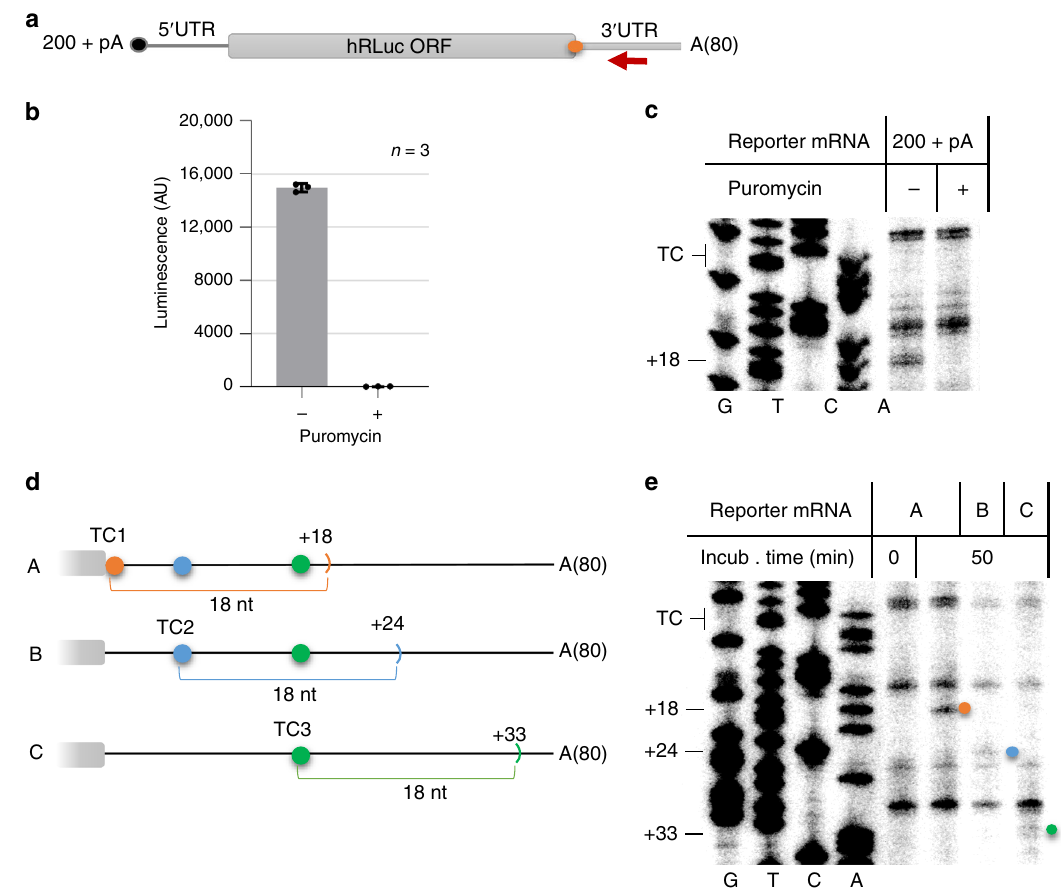
Fig. 1 Toeprint analysis allows the detection of ribosomes at the termination codon of in vitro translated reporter mRNAs. a Schematic representation of the in vitro synthesized capped (black dot) and polyadenylated reporter mRNA coding for humanized Renilla Luciferase (hRluc). The red arrow denotes the radiolabeled toeprint primer binding 66 nts downstream of the TC (orange dot). The 200 nt-long 3 ′ UTR is followed by an 80 nts long template- encoded poly(A) tail depicted as A(80). b Rluc activity measurements of in vitro translation reactions. Luminescence is depicted as arbitrary units (AU), mean values ± standard deviations of 3 technical replicates are shown, values of the individual measurements are indicated by dots. c Toeprint analysis with the 200 + pA reporter transcript shown in a . Translation was performed in HeLa lysates for 50 min in the presence or absence of puromycin. To locate the positions of the toeprints, a Sanger sequencing reaction was run in parallel (G, T, C, A) using the same primer. The positions of termination codon (TC) and the toeprint band 18 nts downstream of the fi rst nucleotide of the TC ( + 18), which originates from ribosomes located at the TC, are indicated. d Schematic representation of in vitro synthesized Rluc reporter transcripts A ( = 200 + pA), B and C, which differ with regards to the position of the termination codon (TC1, TC2, and TC3, respectively). The expected position of toeprints originating from ribosomes at the corresponding TC relative to the original position of TC1 is shown ( + 18, + 24, and + 33, respectively). e Toeprint analysis with the reporter transcripts shown in d . The translation-dependent bands corresponding to toeprints from ribosomes at the respective TCs are marked with dots following color code of d . In vitro translation and toeprint analysis were performed as in c . Source data are provided as a Source Data